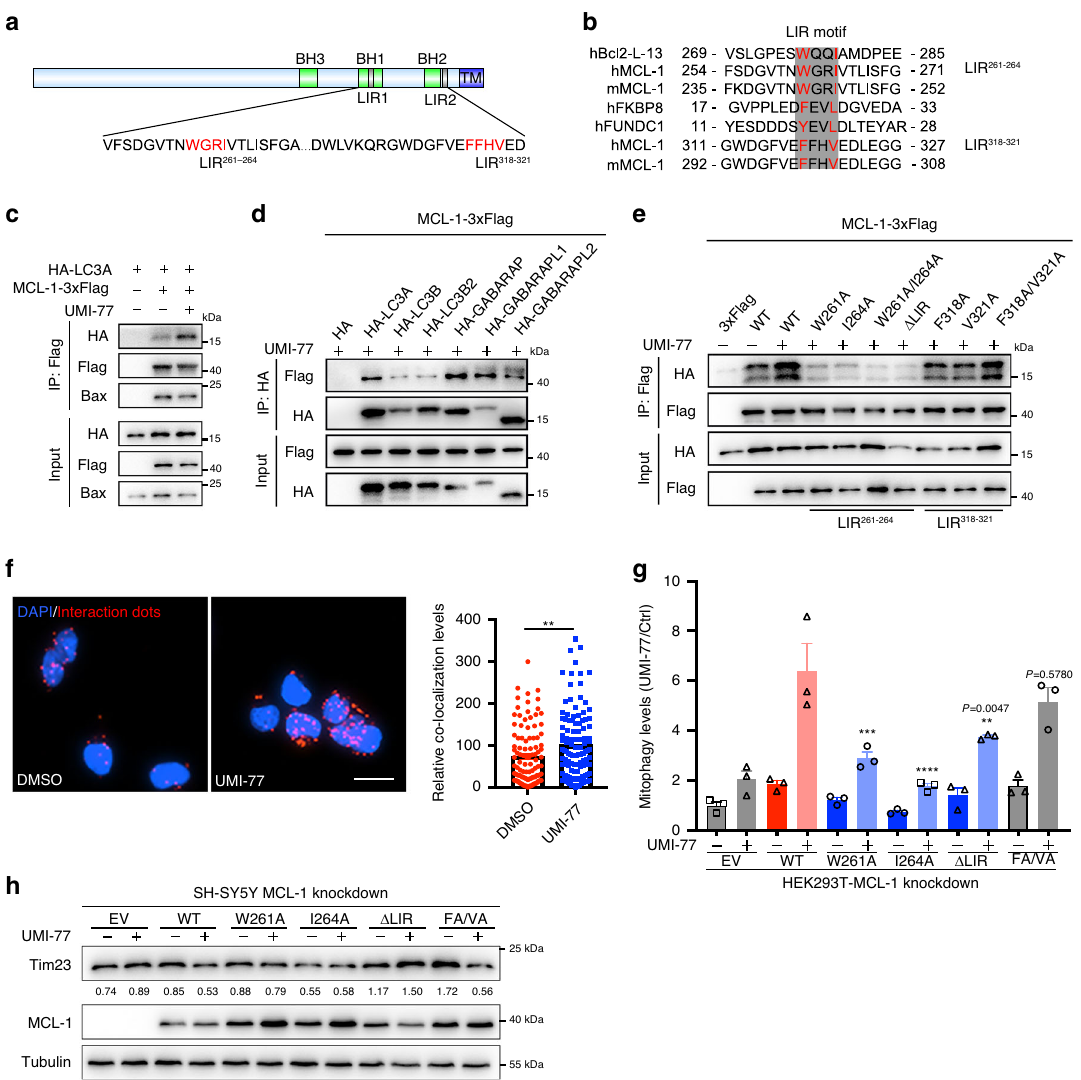
Fig. 3 The interaction between MCL-1 and LC3A is required for UMI-77-induced mitophagy. a The schematic diagram of MCL-1 protein indicating two potential LIR (LC3-interacting region) motifs. The image was created by us in this study. b The alignment of LIR sequences of MCL-1, Bcl-2-L-13, FKBP8, and FUNDC1. Red sequences indicate highly conserved residues in LIR motif. h: Human; m: Mouse. The image was created by us in this study. c HEK293T cells were co-transfected with MCL-1-3xFlag and HA-LC3A for 24 h, treated with UMI-77 (10 µ M) for 4 h, and the interaction of MCL-1 with HA-LC3A and endogenous Bax was analyzed by immunoprecipitation. d HEK293T cells were co-transfected with MCL-1-3xFlag and HA-tagged Atg8 family proteins for 24 h, treated with UMI-77 (10 µ M) for 4 h, and the interaction between MCL-1 and the Atg8 family proteins was analyzed by immunoprecipitation. e HEK293T cells were co-transfected with MCL-1-3xFlag WT or the indicated mutants and LC3A-HA for 24 h, treated with UMI-77 (10 µ M) for 4 h, and the interactions were analyzed by immunoprecipitation. f PLA assay for endogenous MCL-1 and LC3A was performed in HEK293T cells treated with UMI-77 (10 µ M) for 4 h. Scale bar, 20 μ m. Graph on the right – quanti fi cation of the PLA dots (data represents mean ± S.E.M.; DMSO ( n = 107 cells), UMI-77 ( n = 115 cells), ** p < 0.01 ( P = 0.0065), two-tailed t test). g HEK293T-MCL-1-konckdown cell were co-transfected MCL-1 WT or indicated mutants with mt-Keima plasmid for 48 h, treated with UMI-77 (5 µ M) for 12 h. The mitophagy levels were quanti fi ed by one-way ANOVA (data represent mean ± S.E.M.; n = 3, **** p < 0.0001, *** p < 0.001, ** p < 0.01, ns, not signi fi cant.). h SH-SY5Y MCL-1-knockdown cell line was transfected with expression plasmids encoding MCL-1 WT or indicated mutants and treated with UMI-77 (5 µ M) for 12 h. The numbers under the blots represent the gray scale quanti fi cation (Tim23/Tubulin). Source data are provided as a Source Data fi